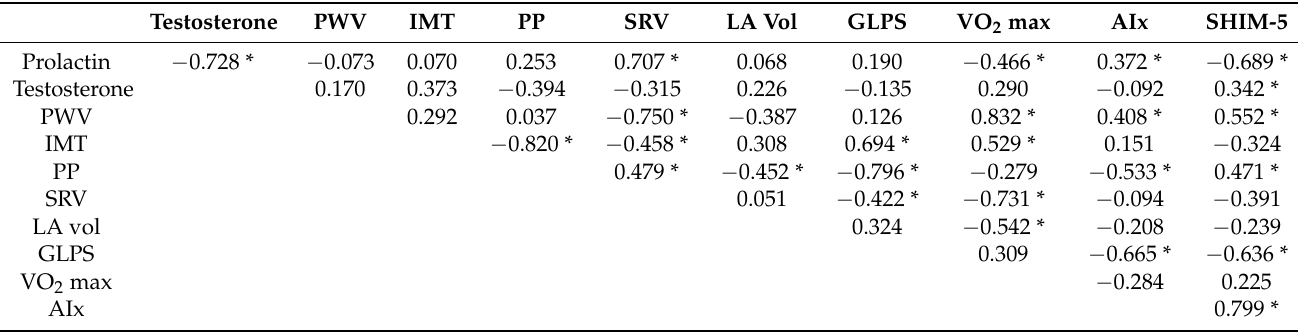
Table 3. Partial correlation coefficients between prolactin, testosterone and cardiac hemodynamic markers, after adjusting for age, BMI, and